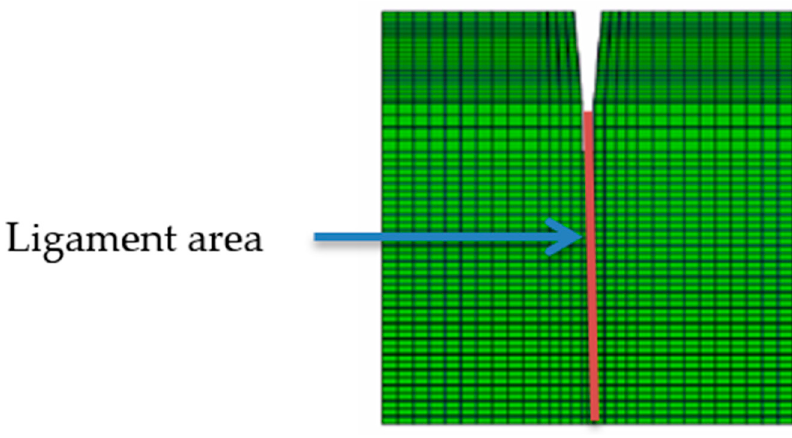
Figure 8. Finite element model geometry and mesh.